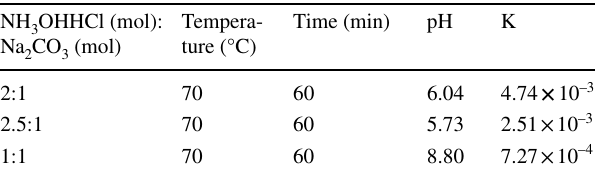
Table 2 The reaction rate constants of amidoximation at different ratios of hydroxylamine hydrochloride and sodium